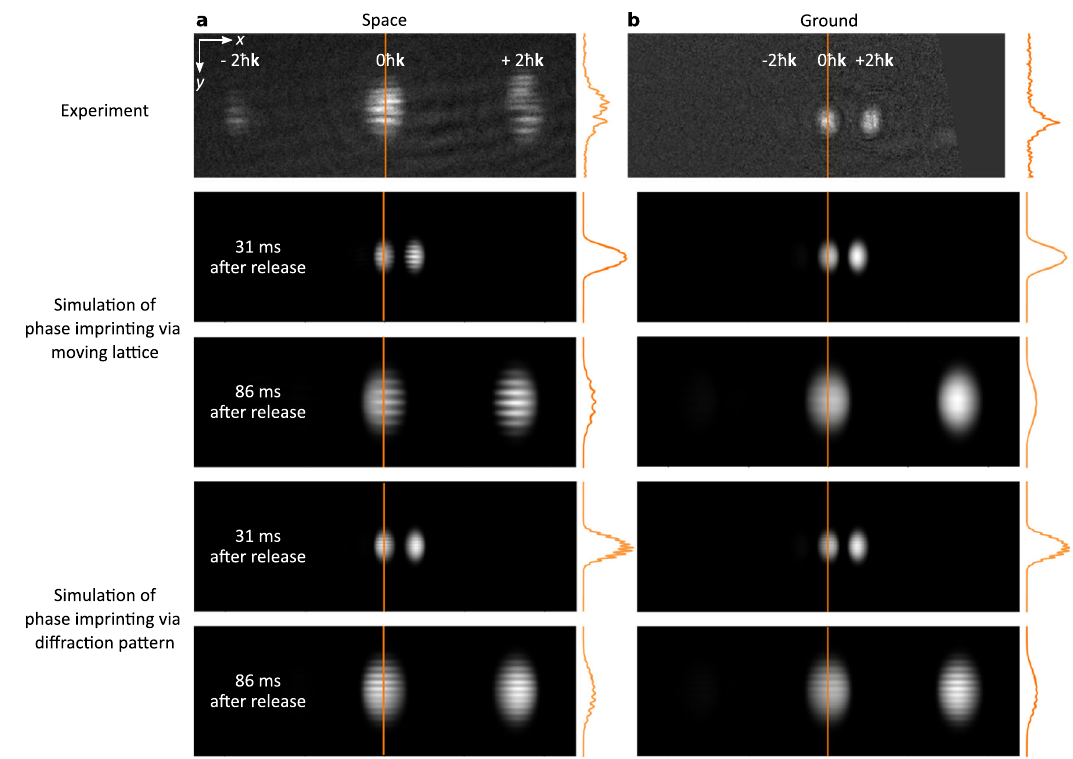
Fig. 2 Effects of a single light-pulse. Depicted are the experimental observations (two upper panels) and theoretical simulations (lower panels) of the impact of a single light-pulse simultaneously inducing Bragg processes and phase imprinting on a matter-wave packet released from the trap in the low gravity environment of space ( a ) (left column), and on ground ( b ) (right column). Each picture shows the undiffracted and the diffracted parts due to Bragg and weak double-Bragg processes. In space, the striking feature is the amplitude modulation of all Bose-Einstein condensates along the y -direction which in our ground experiments was not visible, in accordance with our theoretical simulations. On ground, the free expansion time of the BECs was short (31 ms) to keep them in the Bragg beams and the focal region of the detection. In space, the longer expansion times (86 ms) lead to a larger fringe spacing which allows us to resolve the imprint. In addition, the phase imprinting due to the moving amplitude modulation vanishes on ground due to the Doppler shift caused by the larger detuning between the light beams A and B, resulting in a much larger velocity of the light pattern. In contrast to our model assuming a single BEC component, the experimental fringe patterns feature spatial distortions as well as a much lower contrast. The latter holds even in the case when only a segment of the picture along the y -direction (orange line) is